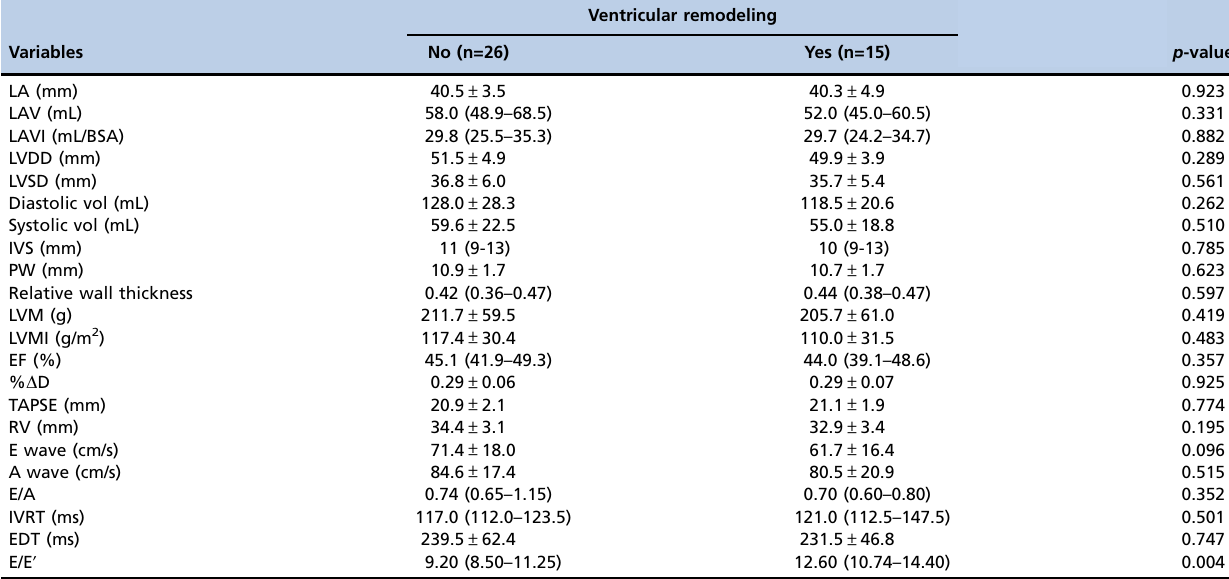
Table 2 - Initial echocardiographic characteristics of patients and ventricular remodeling.